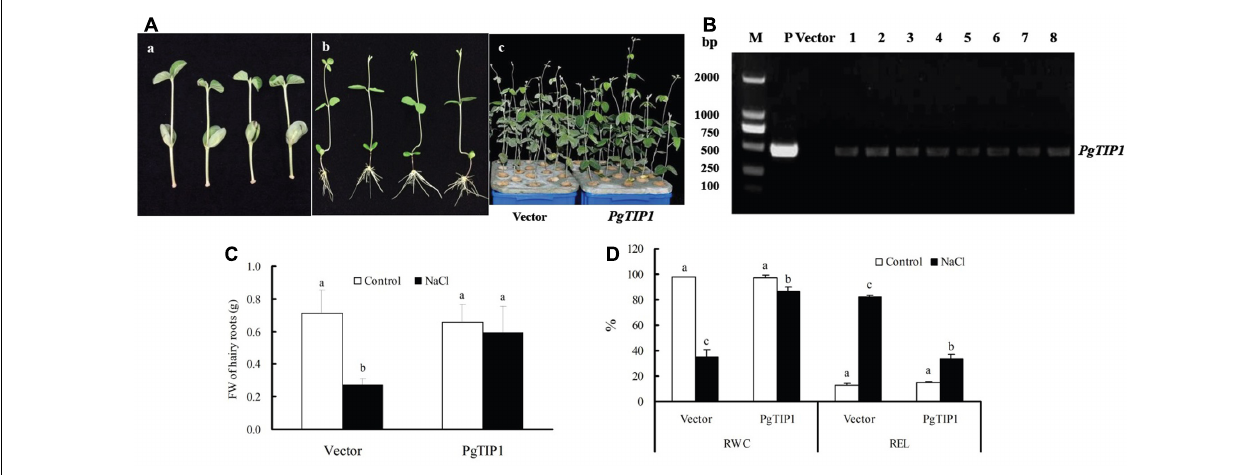
FIGURE 2 | Growth characteristics of PgTIP1- transformed soybean hairy root composite plants under salt stress. (A-a,b) Culture of PgTIP1- transformed soybean hairy root composite plants, (B) PCR verification, (A-c) changes in growth phenotype, (C) FW of hairy roots, and (D) RWC and REL of the 1st pair of unifoliolate leaves under 120 mM NaCl treatment for 5 days. Each bar represents as means ± SD for each treatment ( n = 3), means in bars followed by different letters show significant difference ( P < 0.05) between the parameters of the empty vector - transformed and PgTIP1- transfromed soybean hairy root composite